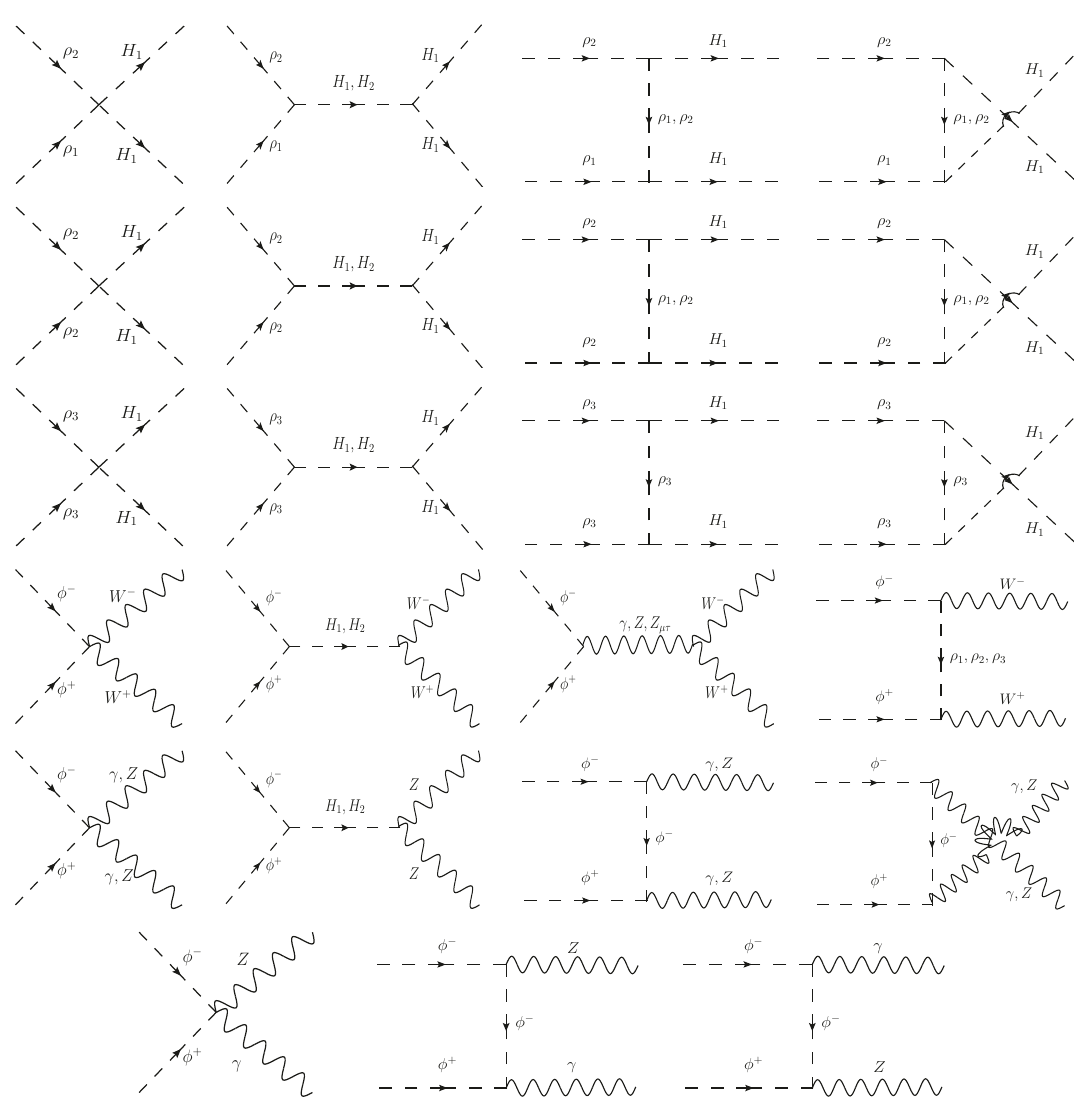
Figure 8 . Co-annihilation channels contributing to the relic density of (cid:26) 1 in the high mass region. In (cid:12)gure 9, we have plotted spin independent scattering cross section (cid:27) SI of (cid:26) 1 with its mass M (cid:26) , varying between 10 GeV to 1 TeV. In this plot all red coloured points satisfy relic 1 density constraint i.e., 0 : 1172 (cid:10) DM h 2 0 : 1226 and bound related to Higgs invisible decay (cid:20) (cid:20) modes as well. The blue dashed-dot line represents the latest bound on (cid:27) SI from XENON1T